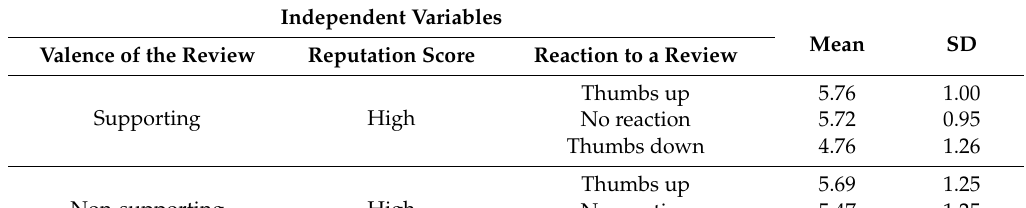
Table 5. Mean values of confidence level.